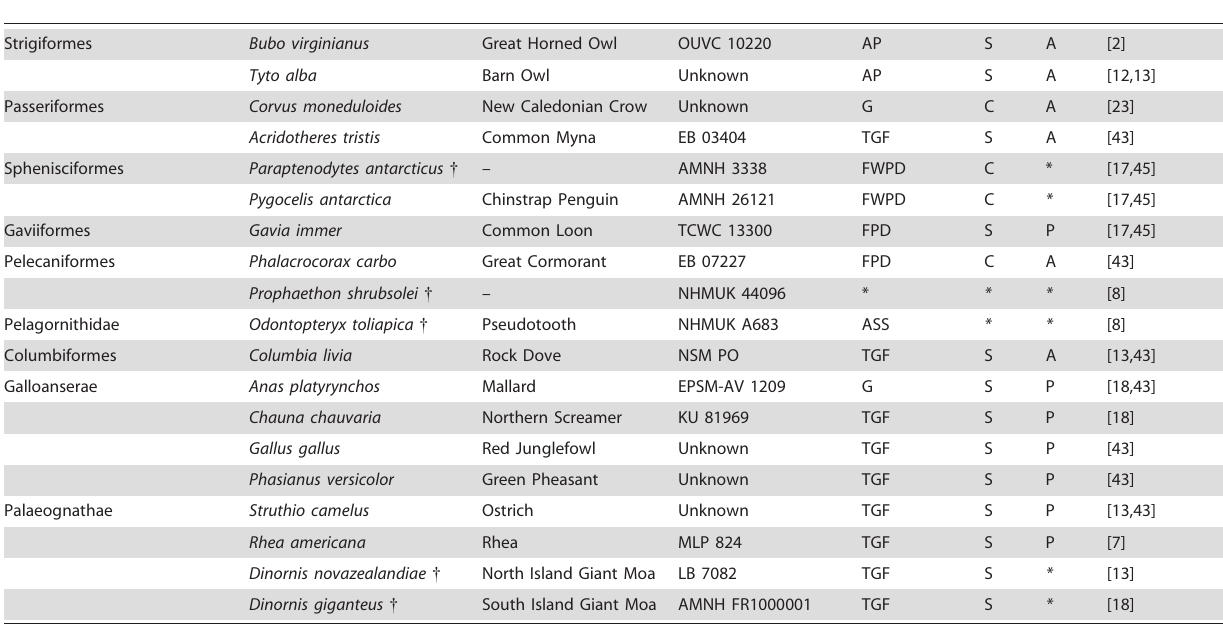
Table 2. Foraging behavior, nesting dispersion, and developmental strategies of sampled outgroup taxa to Charadriiformes.